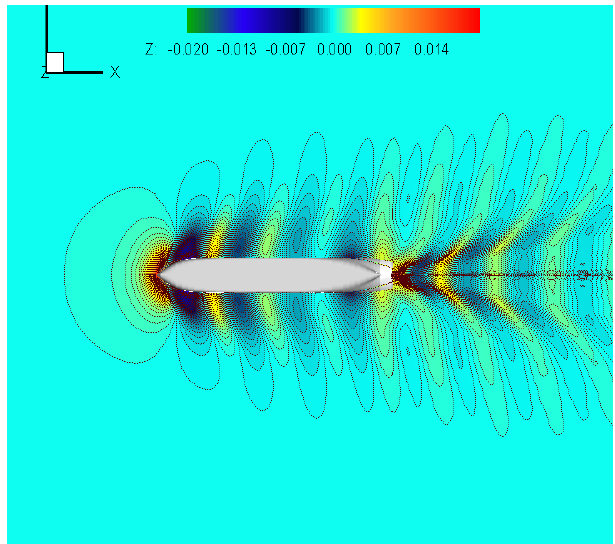
Figure 21. Water elevation contours, model scale, Fn = 0.180.